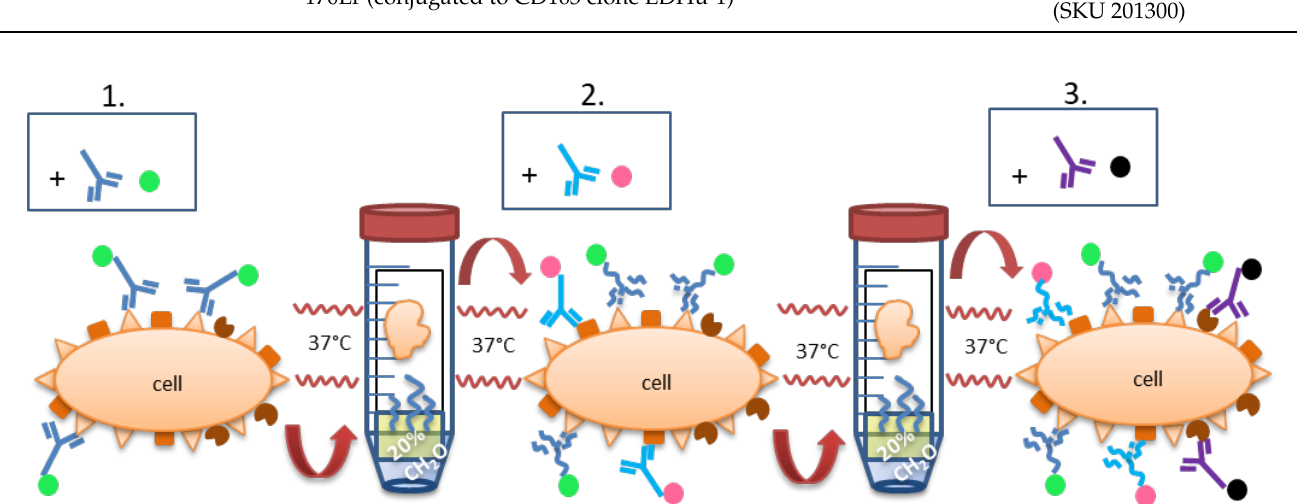
Figure 2. General staining technique: Tissue re-fixation in formalin gas phase. The color dots at the Fc part of the antibodies stand for direct labeling or labeling via secondary antibodies. The latter can be the same throughout the different staining steps because of the formaldehyde-mediated denaturation. ( 1. ) IHC or IF staining is performed as usual, with either a directly labeled primary antibody or with primary + secondary antibody. After the last washing step, the still wet slide is brought into the gas phase over 20% formalin and incubated overnight at 37 °C, leading to re-fixation of the section, denaturation of the antibodies and their fixation on the slide. ( 2. ) Second IHC or IF staining is performed as usual, followed by counterstaining (e.g., with hematoxylin or DAPI) and finalization or followed by the next round of re-fixation and staining ( 3. ).